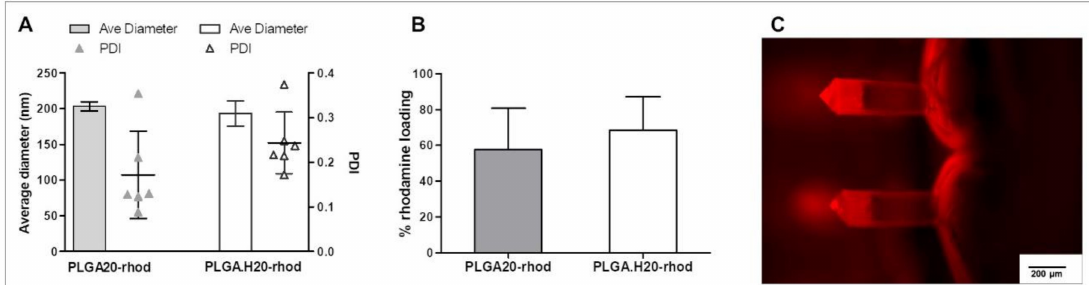
Figure 3. Characterization of PLGA–rhodamine nanoparticles. ( A ) Average diameter of PLGA20 and PLGA.H20 nanoparticles loaded with rhodamine. ( B ) Rhodamine-loading capacity of the PLGA